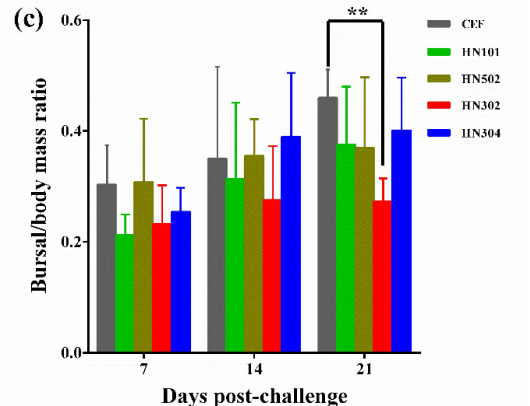
Figure 1. Growth rates and the ratios of bursa or thymus over body mass of chickens challenged with distinct MDVs. ( a ) Growth rates of virus-challenged birds. ( b , c ) Ratios of thymus or bursa over body mass of birds. For each group, the body masses, bursa masses, and masses of five randomly selected birds were measured in the first three weeks post-challenge. Black double stars indicate significant difference ( p < 0.01) to CEF-mock controls.